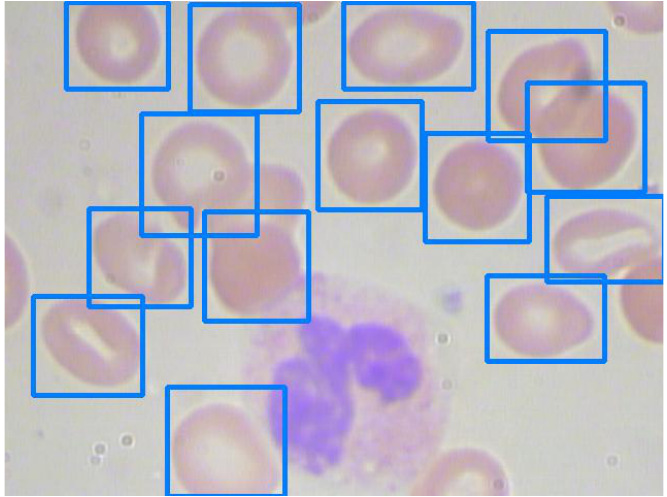
Figure 7. An image with sparse red blood cells. Table 6. Comparison of the experiment results between Figure 7, Figure 8, and the validation set. Confidence Score: 0.9